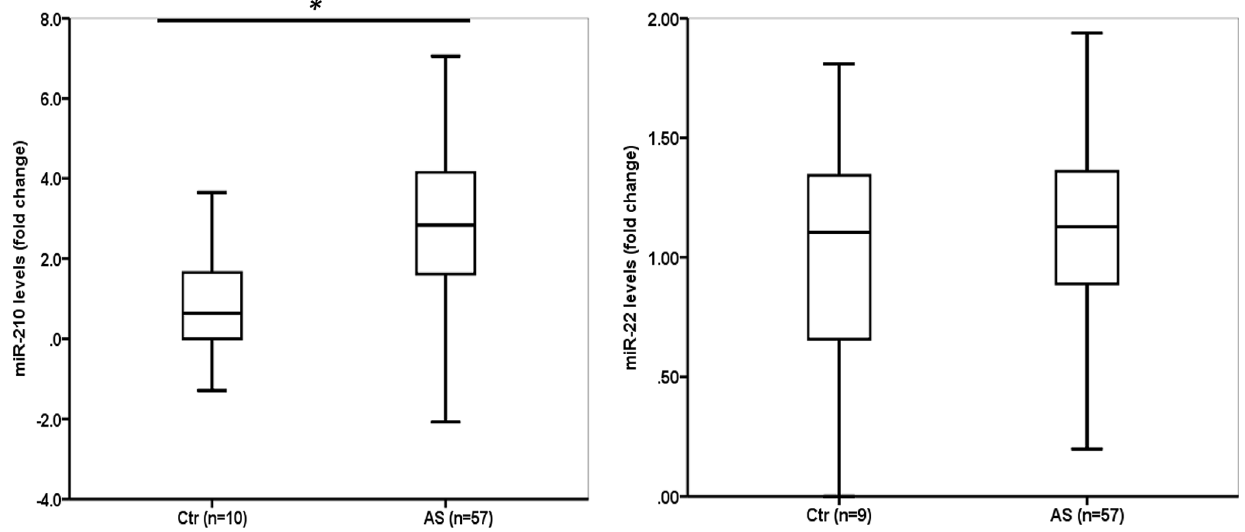
Figure 2. miR-210 levels were significantly increased in patients with AS compared to age- and gender-matched control subjects, whereas miR-22 levels were not altered. The horizontal line within the box represents the median level, the boundaries of the box quartiles 1–3, and the whiskers range (maximum value restricted to 1.5 6 interquartile range from the median). *p , 0.01.